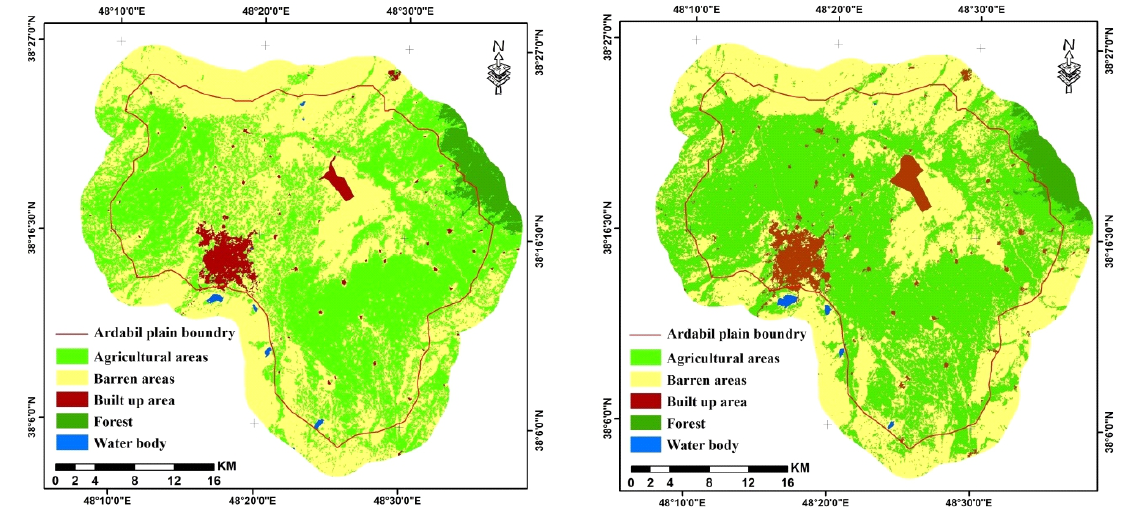
Fig. 4: Landuse/cover classification map 1998Fig. 3: Landuse/cover classification map 1989